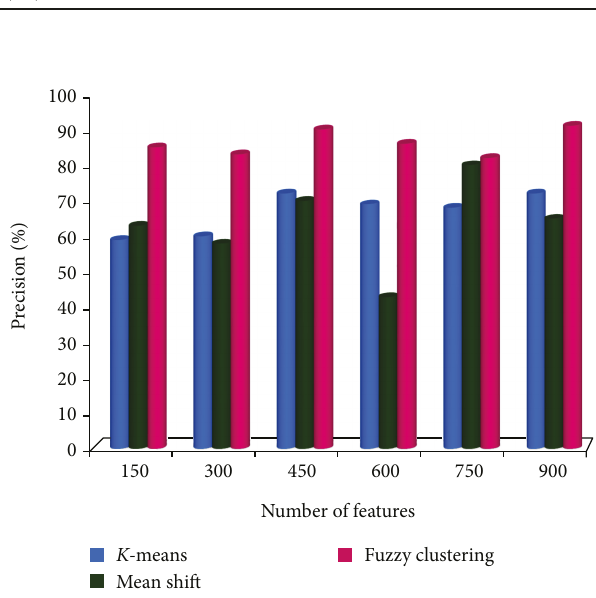
Figure 2: Result of feature